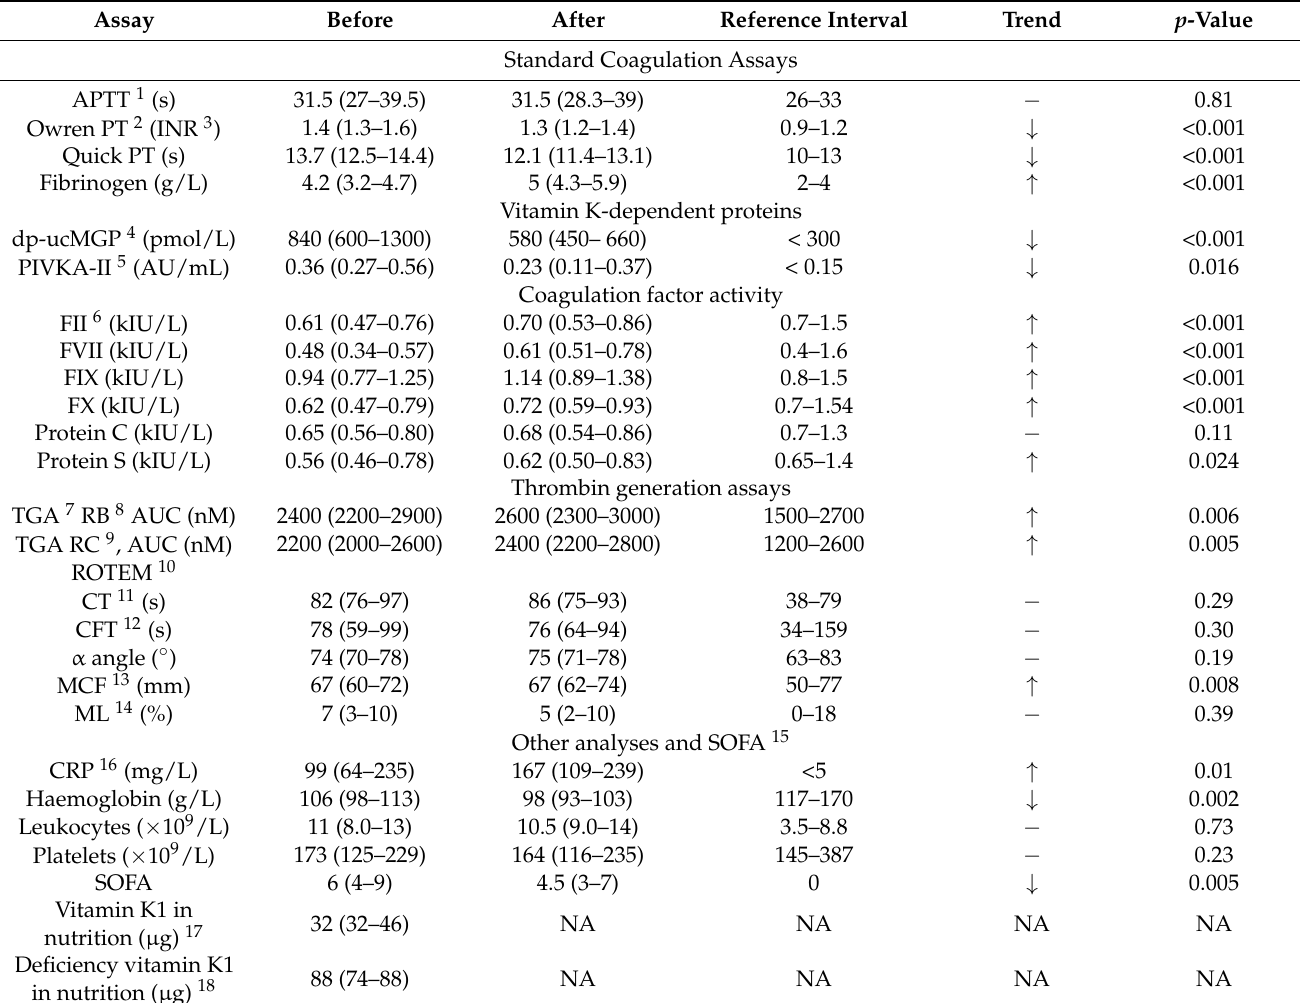
Table 2. Assay values before and after vitamin K1 administration presented as median (IQR). n =